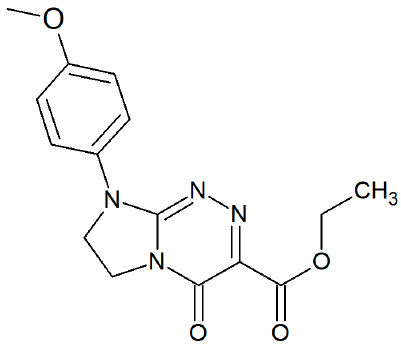
Figure 1. The structure of the investigated EIMTC.